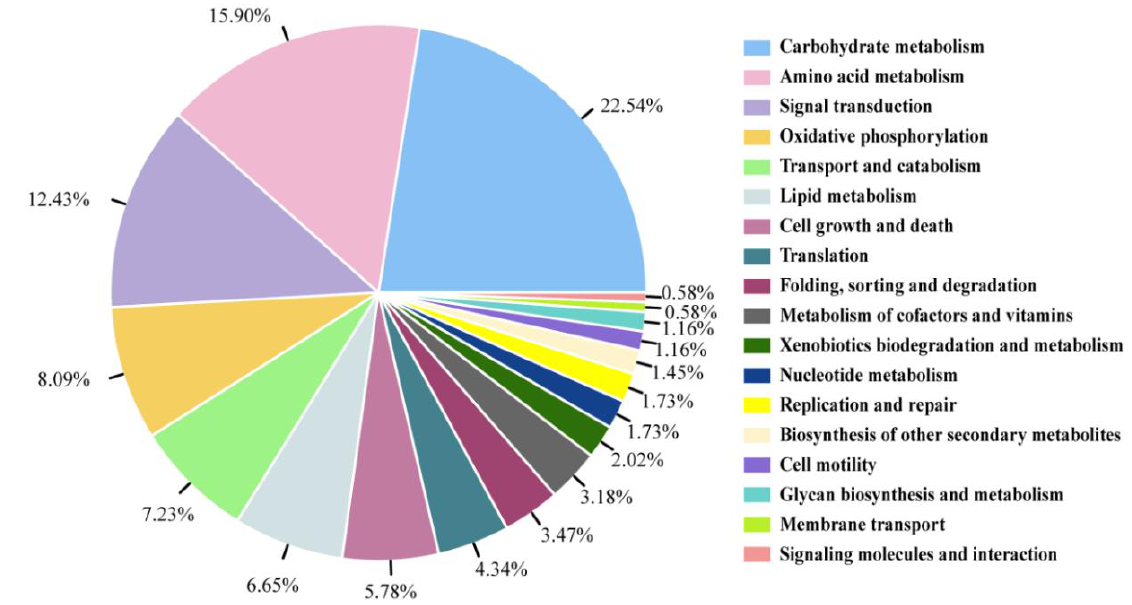
Figure 4. Functional distribution of the 346 mitochondrial proteins.